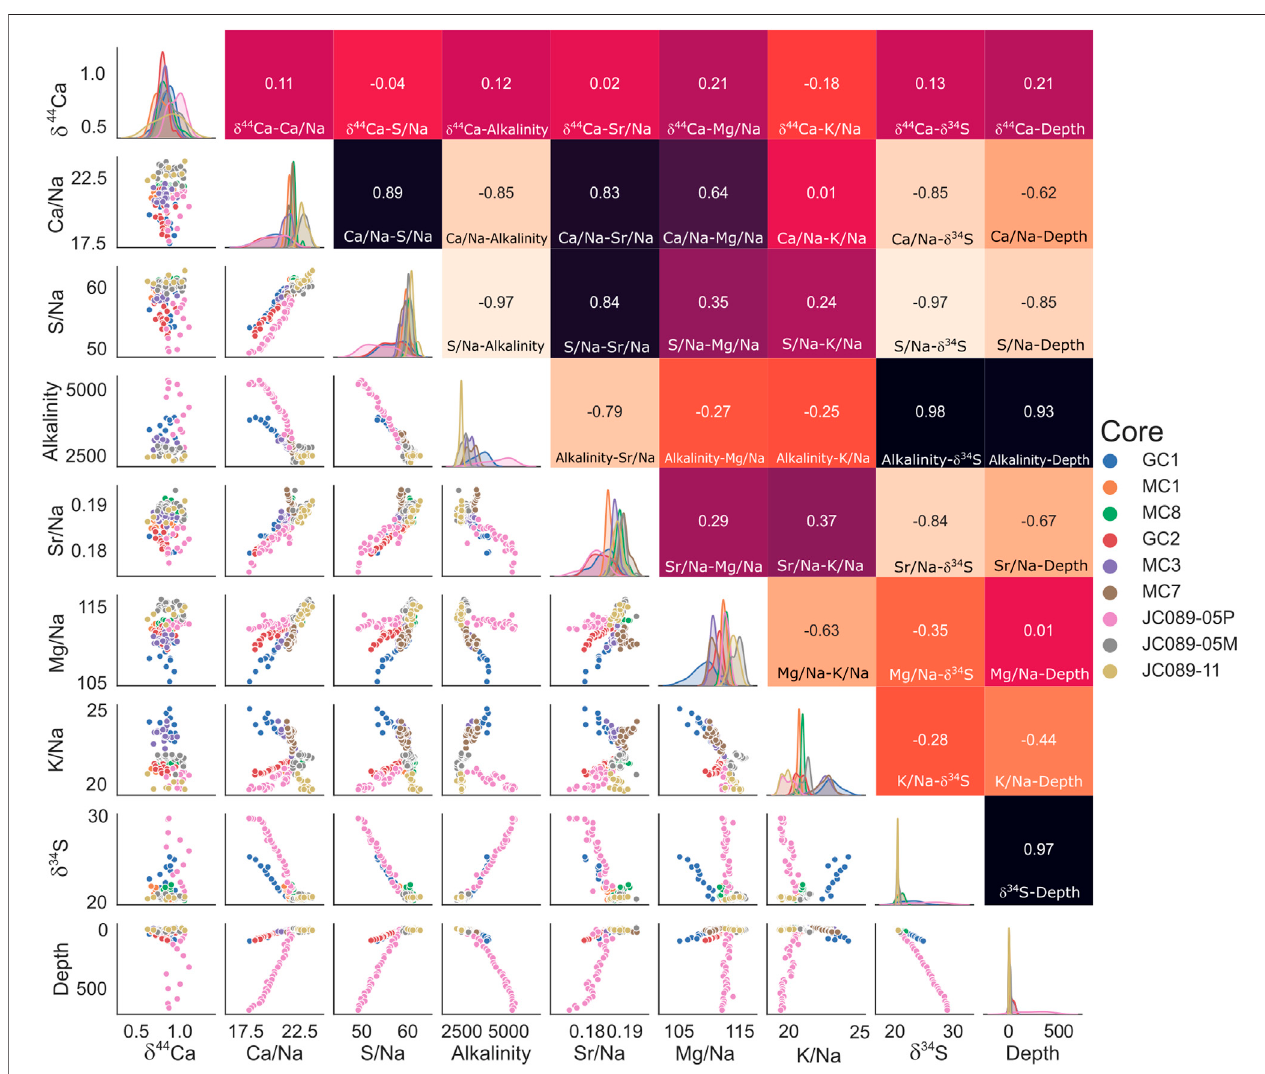
FIGURE4| Correlationsbetweenpore fl uidspecies:allconcentrationsareherenormalizedtolocalsalinitytoallowcomparisonbetweensites. Topright quadrant: least squares regression coef fi cient (R)betweencorrespondingpore fl uid species, color-coded fromwhite( – 1)throughred(0)toblack(1). Bottomleft quadrant:Cross plotsofspecies,color-codedbycoreasperthelegend (right) . Centraldiagonal :frequencydensityofdataforthecorrespondingspeciesintheplottedrange,bycore.